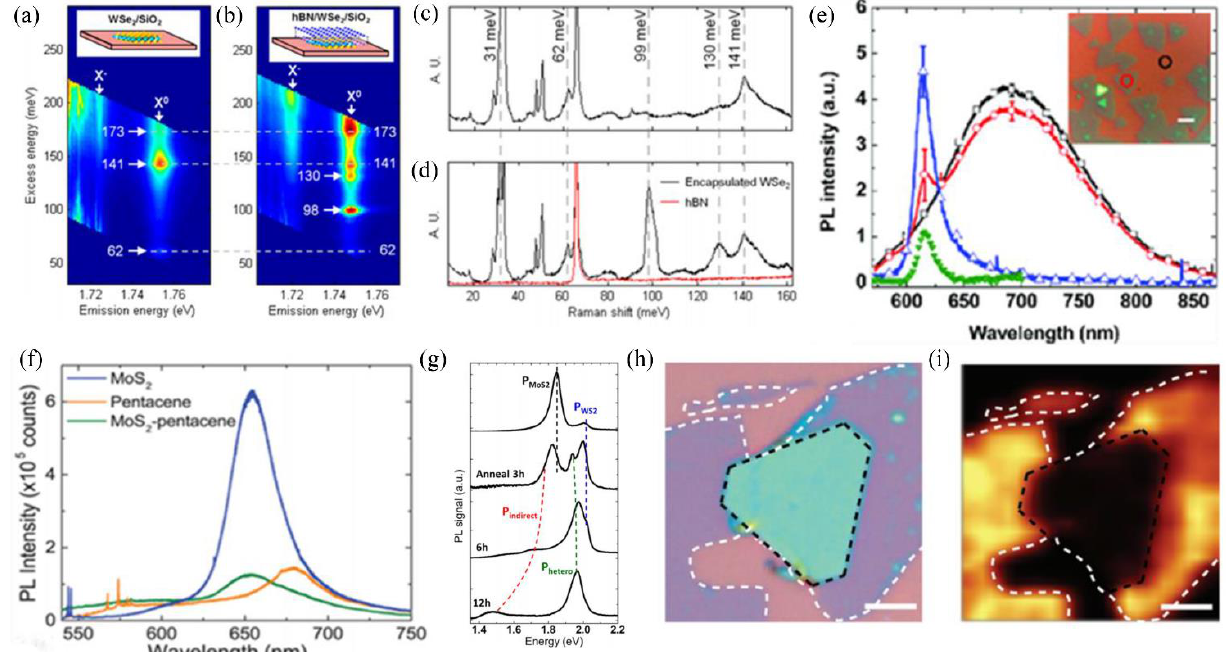
Figure 4. ( a , b ) PLE intensity plots of WSe 2 /SiO 2 and hBN/WSe 2 /SiO 2 [76]. ( c ) Raman spectrum of WSe 2 /SiO 2 sample [76]. ( d ) Raman spectra from hBN/WSe 2 /SiO 2 sample and hBN.